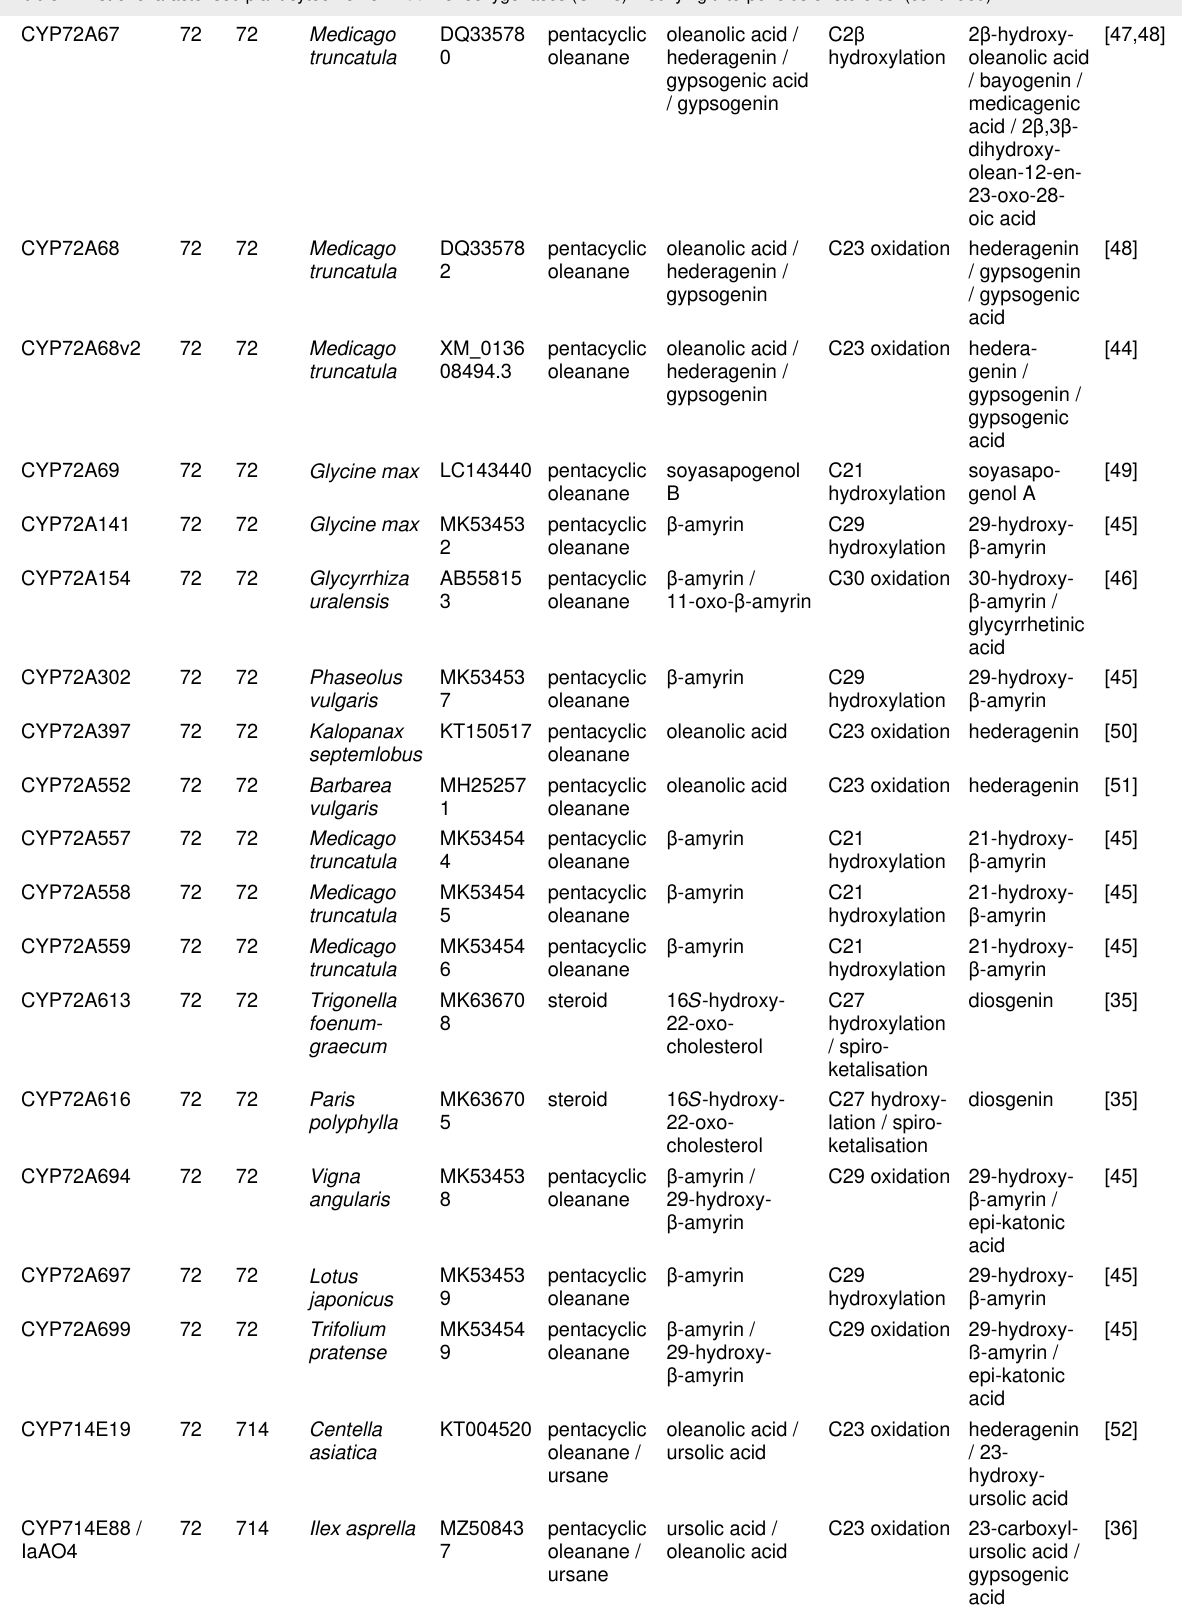
Table 1: List of characterised plant cytochrome P450 monooxygenases (CYPs) modifying triterpenoids or steroids. (continued)